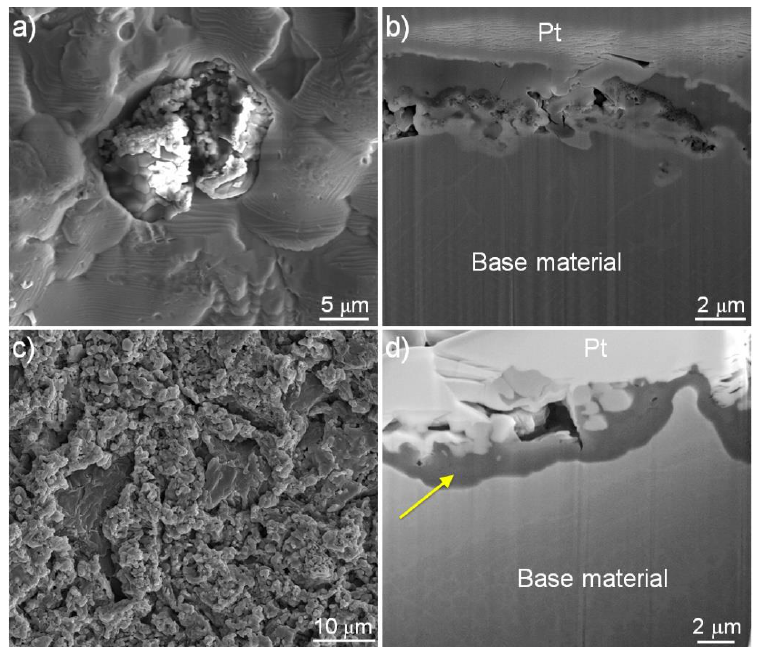
Figure 4. SEM images acquired from a scaled region ( a , b ) and an unscaled region ( c , d ): ( a ) a plain view of an interested region, ( b ) a tilting view after FIB milling on the central region in ( a ), ( c ) a plain view of an interested region, and ( d ) a tilting view after FIB milling. Note that a platinum layer was deposited on the region of interest in ( a , c ), respectively, to protect it during FIM milling, and the surface in ( c ) was gold-coated for conduction during SEM observation.